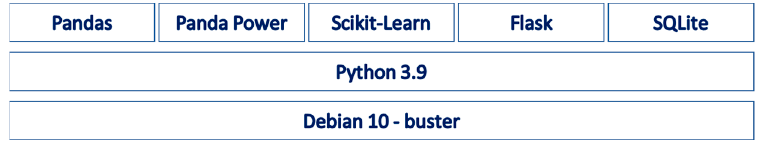
Figure 6. High-level architecture of the edge processing module software stack.